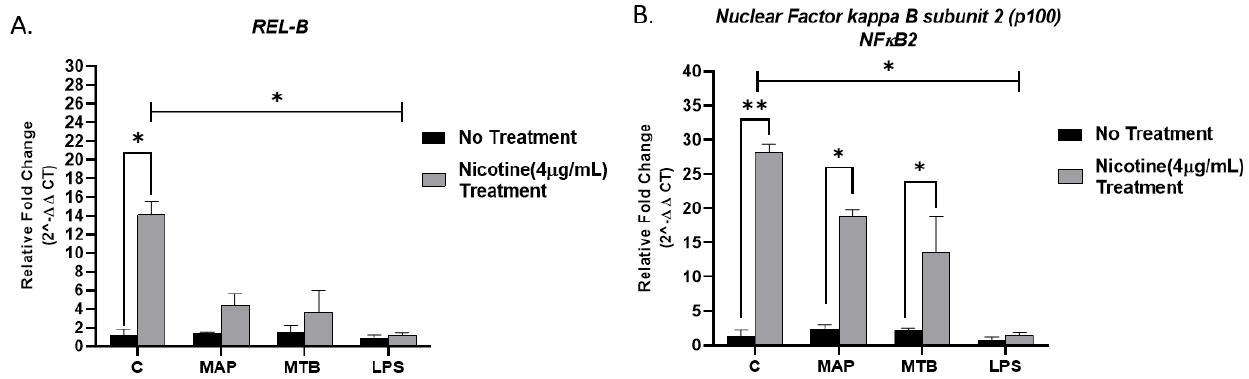
Figure 4. Effect of nicotine on the ( A ) REL-B and ( B ) NF-kB p100 subunit expressions in infected macrophages. THP-1 PMA differentiated macrophages were infected with MAP and MTB, or treated with LPS for 24 h, then treated with nicotine (4 µg/mL). Expression of REL-B and NF- ĸ B p100 were measured by RT-PCR. All experiments were performed in duplicate. MAP: Mycobacterium avium paratuberculosis . MTB: Mycobacteria tubercalusis . LPS: lipopolysaccharide derived from Escherichia coli ATCC 8739. * p < 0.05, ** p < 0.001. Table 2. Activation Score of Phosphorylated NF- κ B p100/p52